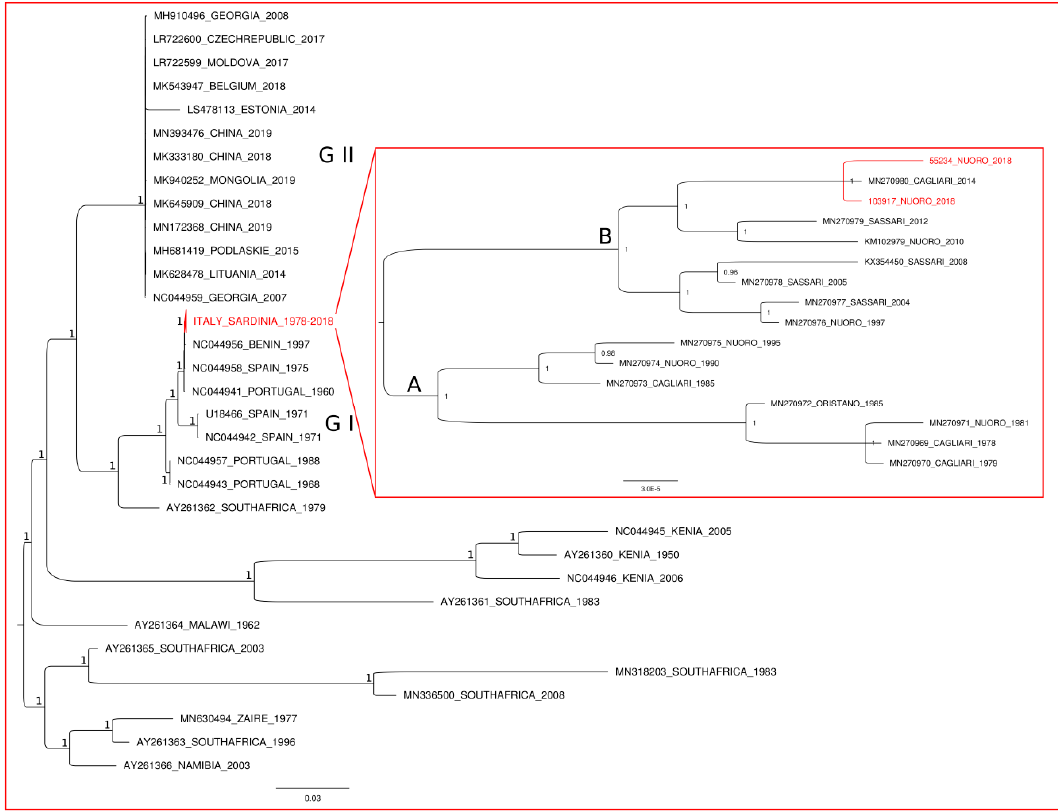
Figure 4. Bayesian phylogenetic tree based on ASFV complete genome sequences. The main nodes of the tree are fully supported by values of posterior probabilities = 1. The clade, including the 16 Sardinian ASFV genomes, was collapsed in the main tree and indicated with red font. In the inset are the phylogenetic relationships within the Sardinian group. The sequences isolated in the present study are indicated in red font.